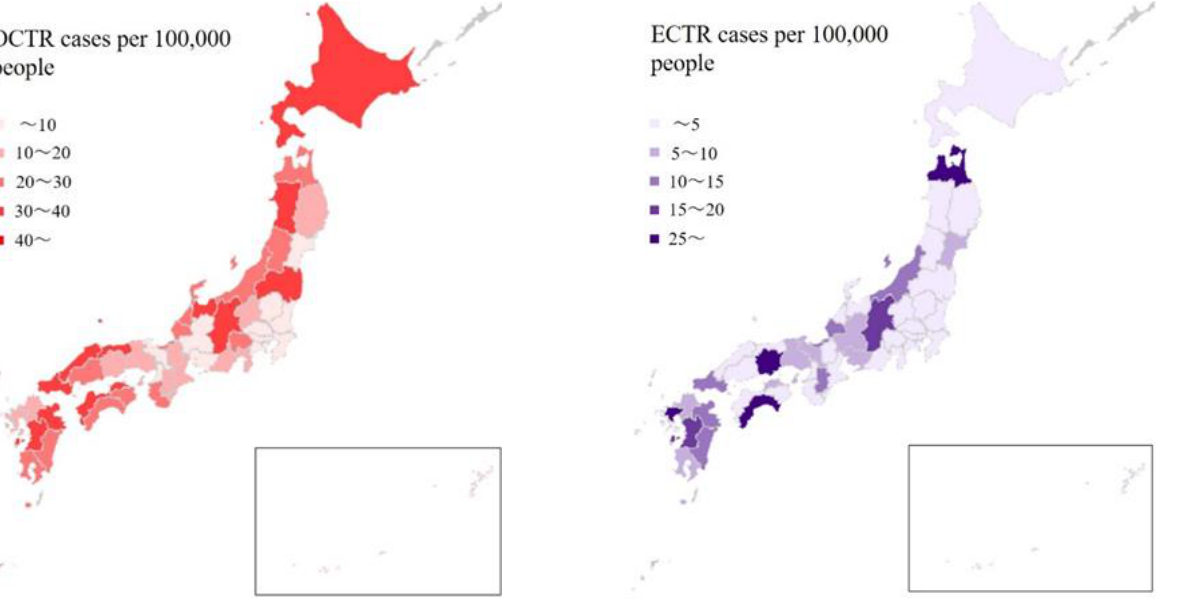
Figure 4. Mean annual open carpal tunnel release (OCTR) and endoscopic carpal tunnel release (ECTR) cases per 100,000 people by prefecture.